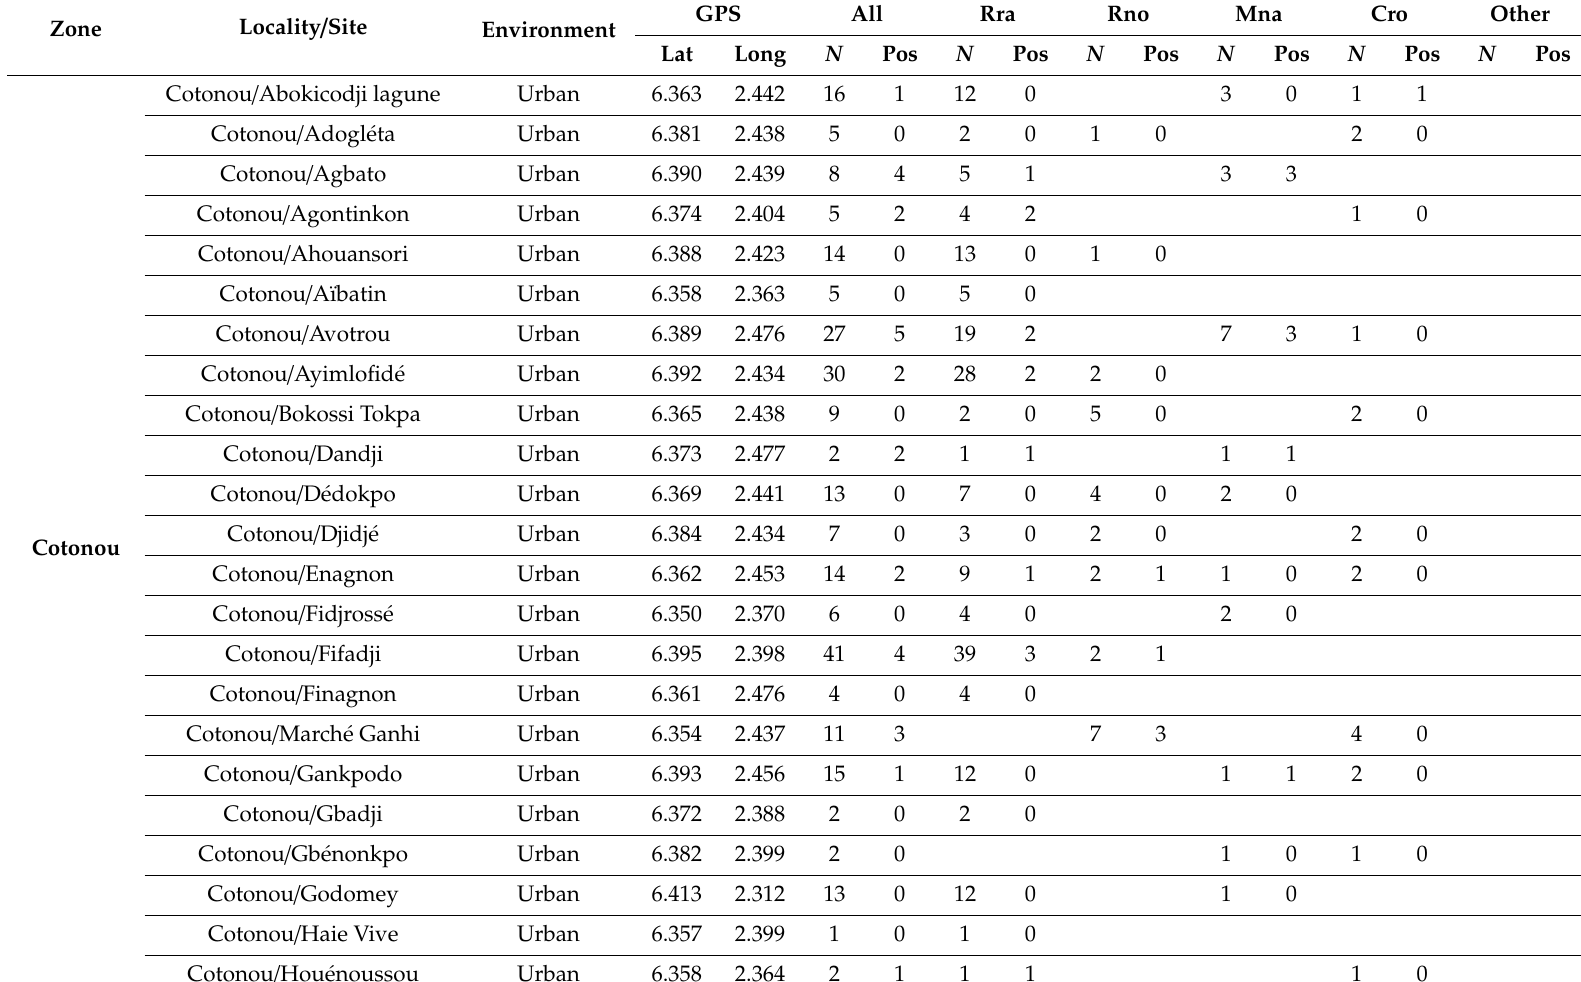
Table 1. Small mammal-borne pathogenic Leptospira prevalence at each zone and site in south Benin. Zone Locality / Site Environment